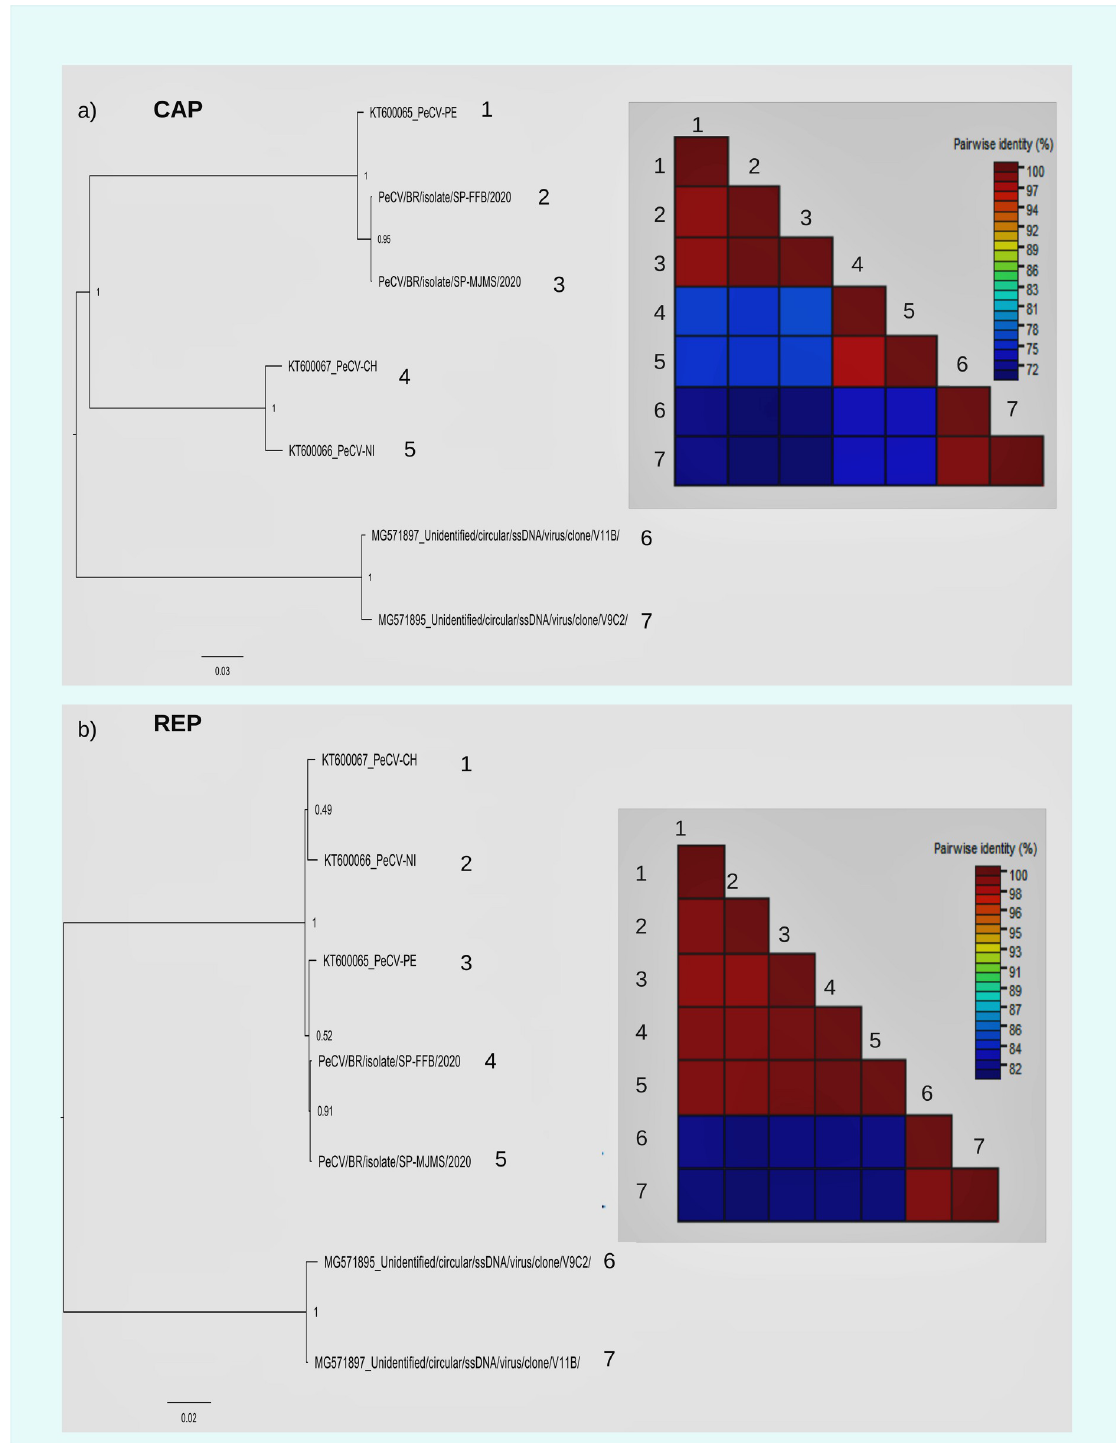
Fig 4. Similarity of CAP and REP proteins in members of CRESS DNA viruses. Diagrams indicate the similarity of the translated CAP (a) and REP (b) proteins in members of pecoviruses and circoviruses. The similarity percentages are indicated by colors according to the scale pattern indicated in each diagram. Maximum likelihood tree of genome of pecovirus and circoviruses. Tree was inferred in FastTree using GTR+ gamma correction and the proportion of invariable sites model as selected by the jModeltest software. Branch support was achieved by approximate likelihood ratio test (aLRT) and is shown in a color